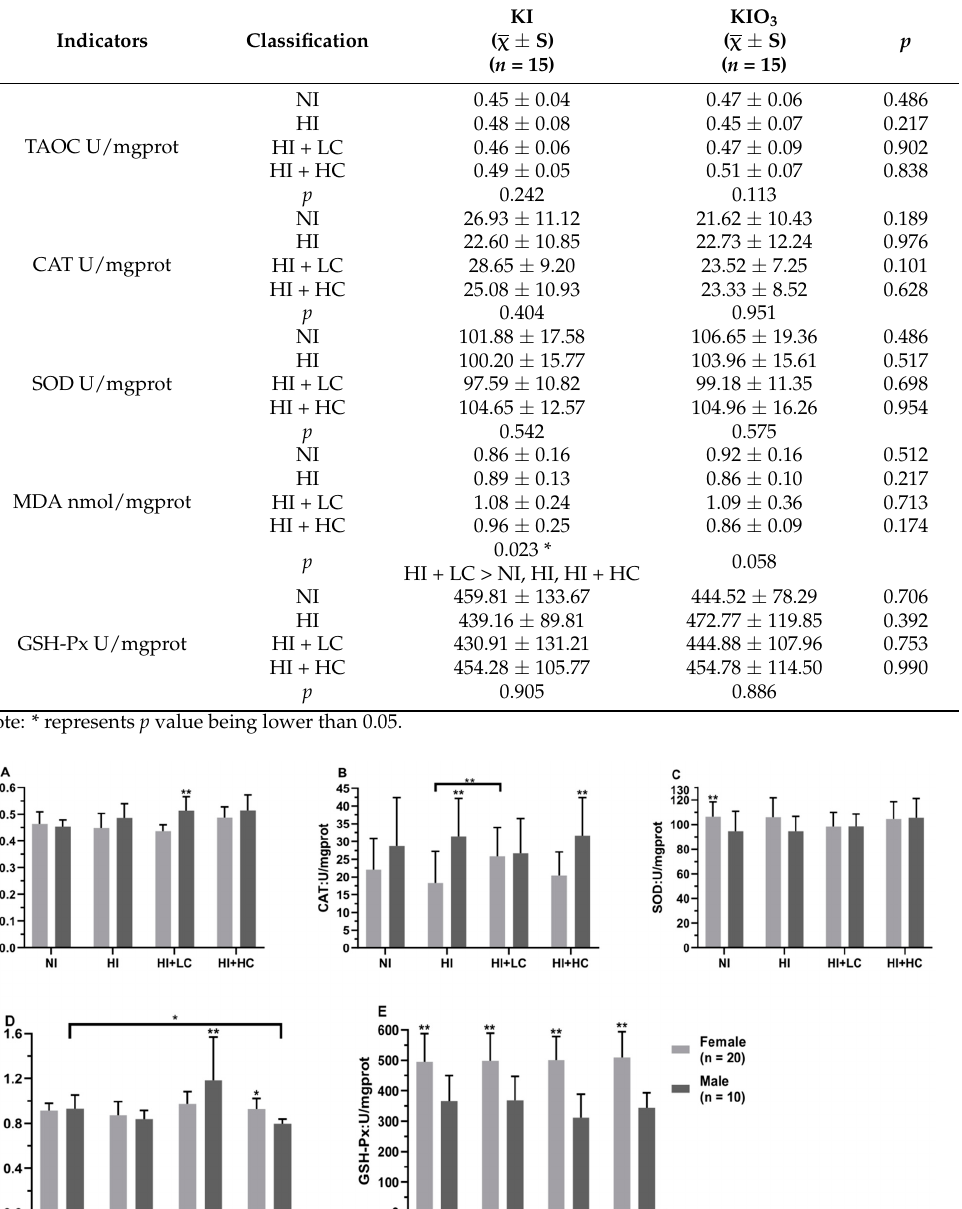
Table 2. Protection of vitamin C from oxidative damage in liver.